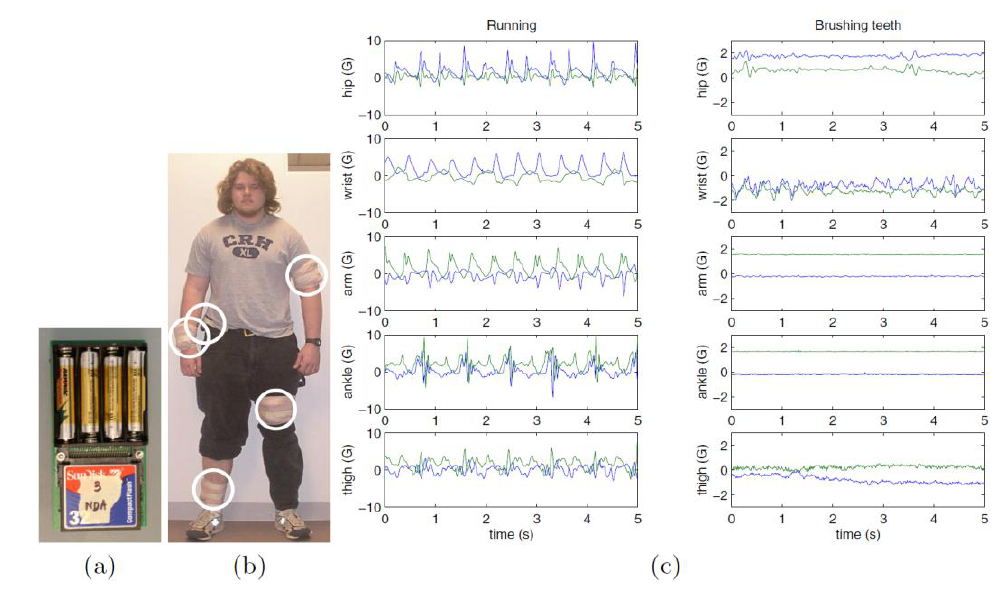
Figure 4. Experimental setup for the acquisition of the selected dataset (courtesy of Ling Bao and Stephen S. Intille © 2004 IEEE).